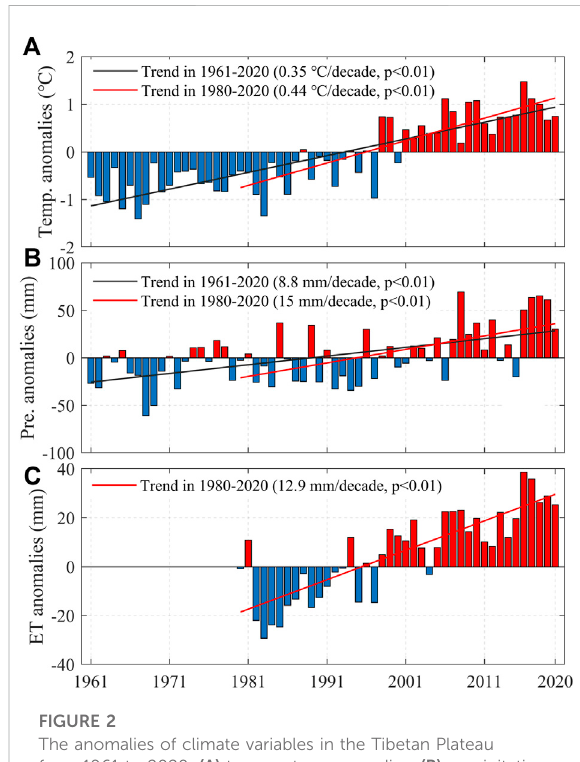
FIGURE 2 The anomalies of climate variables in the Tibetan Plateau from 1961 to 2020, (A) temperature anomalies, (B) precipitation anomalies, and (C) evapotranspiration (ET) anomalies (from 1980 to 2020). The base period of anomalies is 1981 –